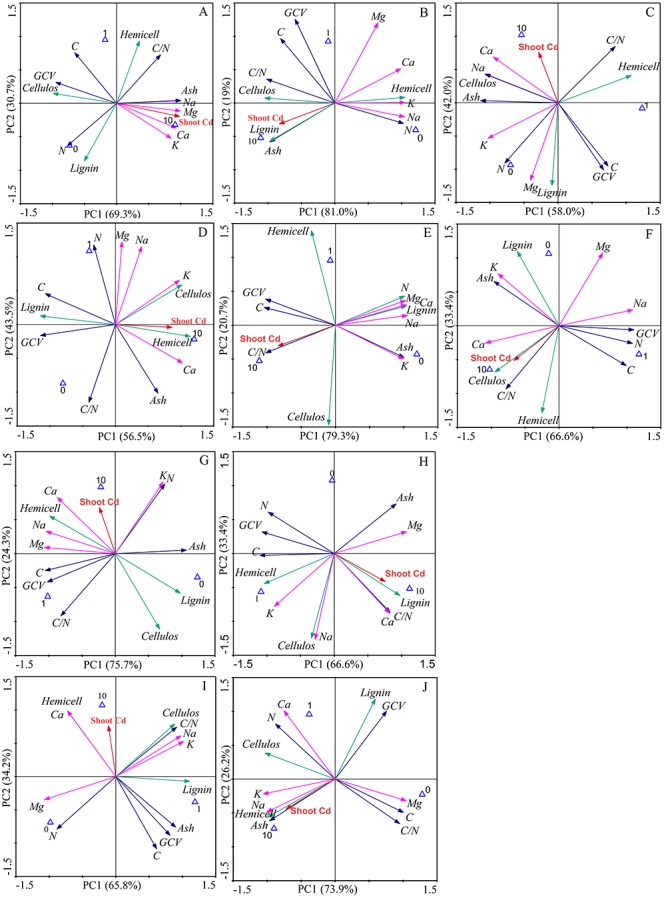
Principle component analysis of bioenergy quality-related factors of five switchgrass cultivars with NM and M treatments under Cd stress.(A, D) represent non-inoculated with AMF (NM) and inoculated with AMF (M) treatments in Ala. (B, E) represent NM and M treatments in Kan. (C, F) represent NM and M treatments in Per. (G, I) represent NM and M treatments in Bw. (H, J) represent NM and M in treatments Sum. Different colors of arrows among the factors represent corresponding bioenergy quality (green: cellulose quality; pink: alkaline elements, blue: other factors). The blue triangle represent the Cd addition level (0, 1, 10 mg/kg).